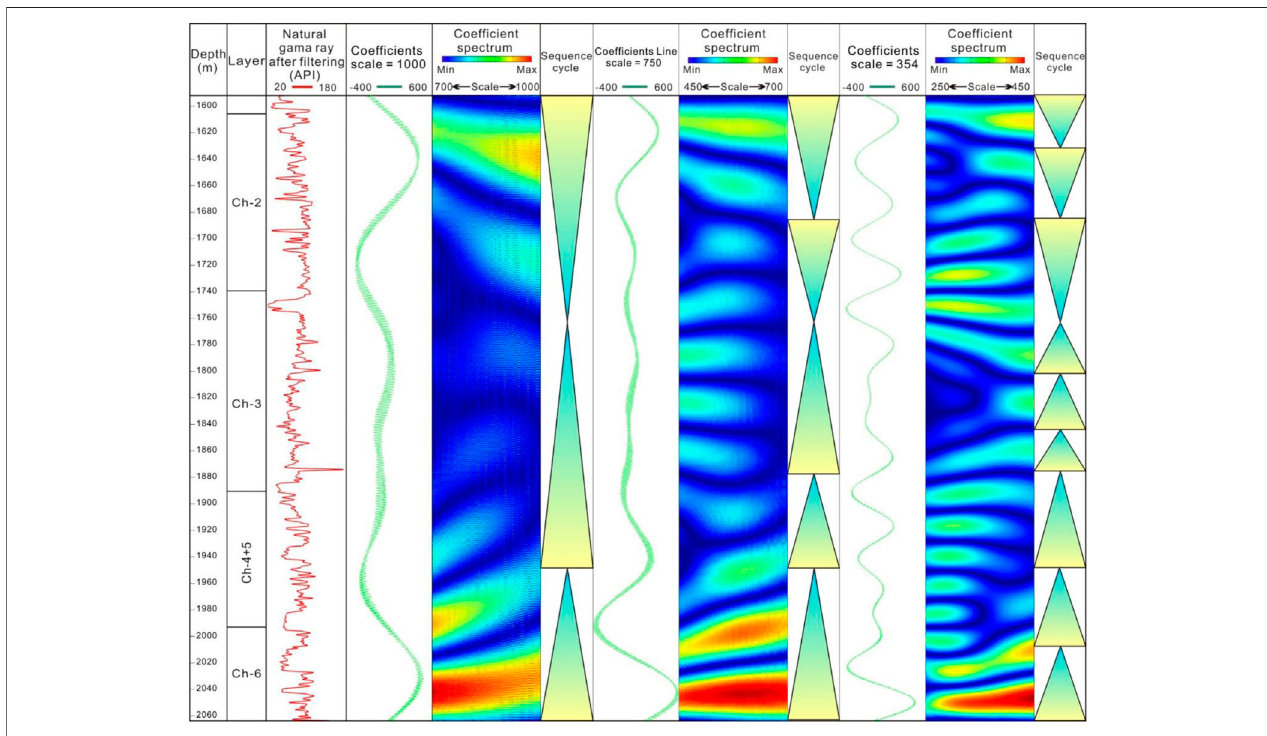
FIGURE 15 | Recognition results of sedimentary cycle based on CWT